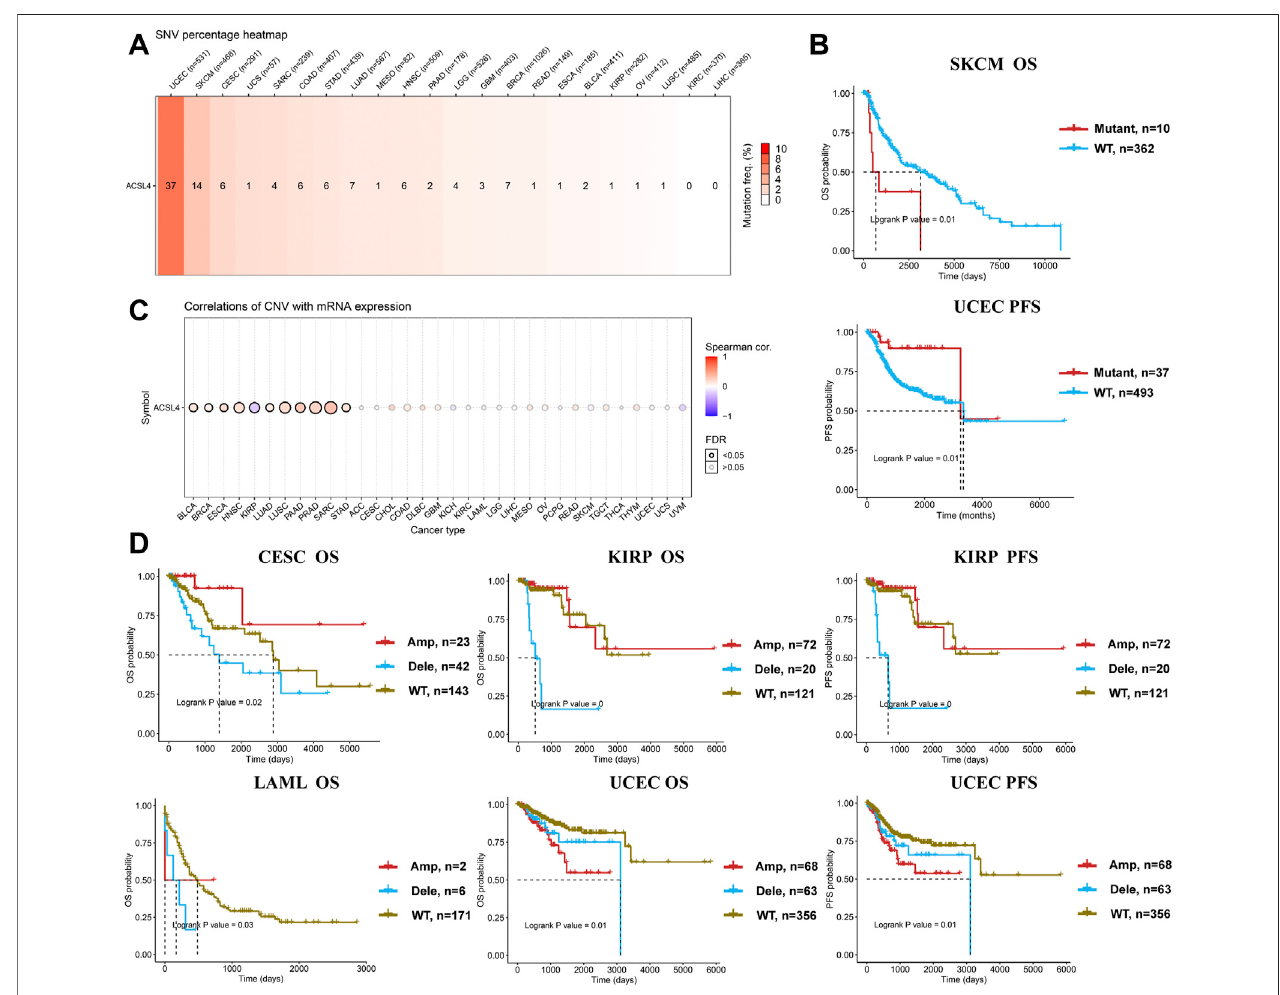
FIGURE 5 | Genetic alterations of ACSL4 in different cancers from the GSCA database. (A) . SNV percentage heatmap of ACSL4 in different cancers. (B) . Correlation between ACSL4 mutant and prognosis in SKCM and UCEC. OS of SKCM (skin cutaneous melanoma); PFS of UCEC ((uterine corpus endometrial carcinoma). OS, overall survival; PFS, Progression-free survival. (C) . Correlation of CNV with mRNA expression in different cancers. (D) . Correlation between ACSL4 CNV and prognosis in different cancers. OS of CESC (cervical squamous cell carcinoma); OS and PFS of KIRP (kidney renal papillary cell carcinoma); OS of LAML (lacute myeloid leukemia); OS and PFS of UCEC (uterine corpus endometrial carcinoma). OS, overall survival; PFS, Progression-free